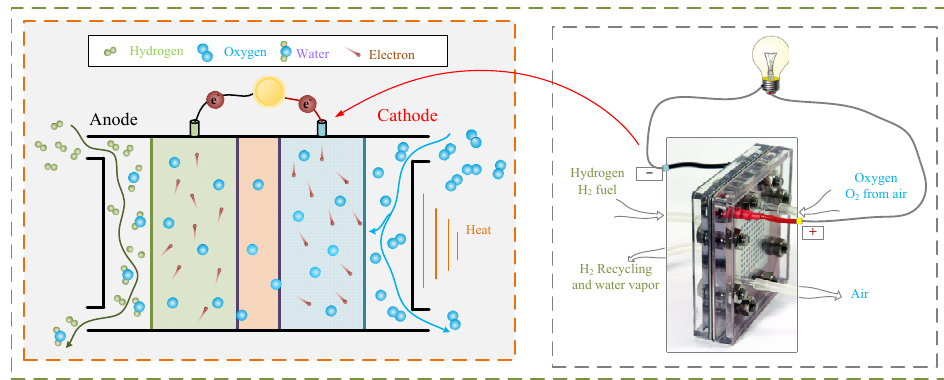
Figure 2. Electrochemical operation mechanism of SOFC [17].